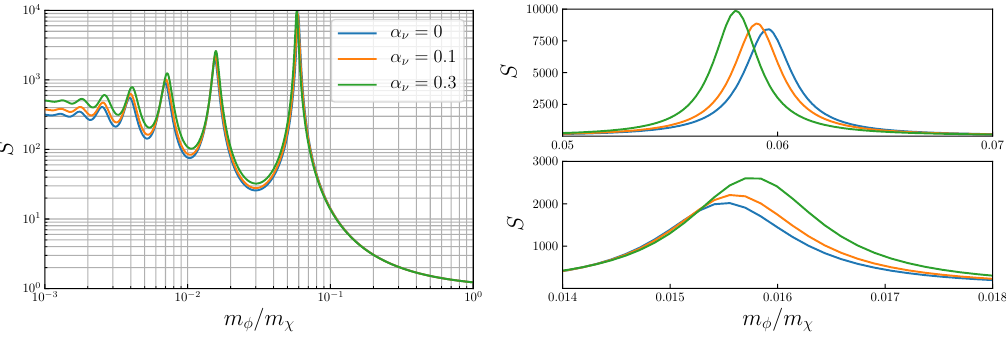
Figure 4 . The Sommerfeld enhancement factor S as a function of the t -channel mediator mass m φ . The effective potential used to obtain these curves is given in eq. (3.6), assuming α ν = { 0 , 0 . 1 , 0 . 3 } and α χ = 0 . 1 . The left panel shows the entire mass range whereas the right panels focus on the two highest